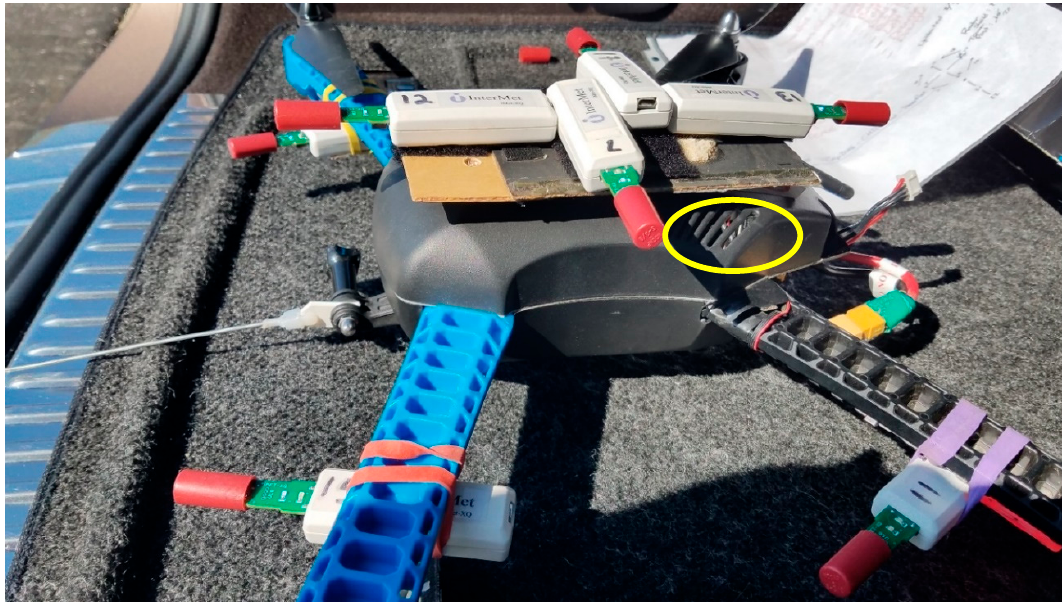
Figure 8. Photograph of the UAV showing the battery compartment vent on the left side of the UAV (yellow ellipse) towards the rear of the UAV, and the locations of several iMET-XQ sensors.